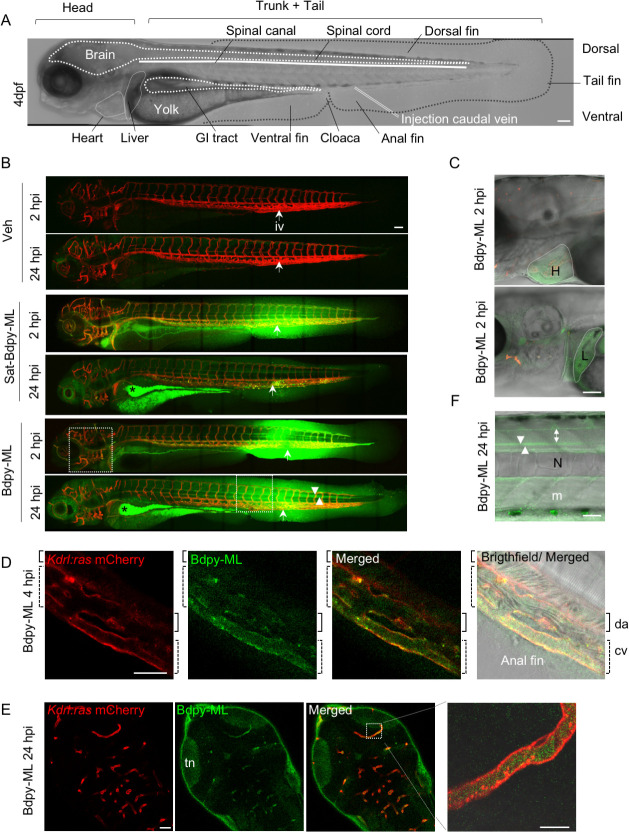
In vivo diffusion of Bdpy-ML in zebrafish larva.(A) Brightfield lateral view of a larva at 4 dpf with main anatomical structures highlighted. GI, Gastro-intestinal. (B) lateral views of 4dpf zebrafish Kdrl:Ras mCherry larvae, 2 and 24 hours post injection (hpi) in the caudal vein with vehicle (Veh), Sat-Bdpy-ML or Bdpy-ML. Images are maximal z projections of confocal tile scan images acquired on same larvae over time; mCherry fluorescence shown in red, Bdpy in green. Arrowheads indicate the spinal canal, arrows indicate the site of intravenous injection (iv), stars show accumulation in the GI tract at 24h. Areas delimited by dotted lines in (B) are shown at higher magnification in (C, 2 hpi) and (F, 24 hpi). Scale Bar 100 μm. (C) Enlarged views (with transmitted light image overlaid on fluorescence) of (B) showing accumulation of Bdpy-ML in heart and liver 2 hpi. (D) Detail of the vasculature in the ventral region of the tail showing longitudinal section of blood vessels and colocalization of Bdpy-ML with mCherry in endothelial cells of the caudal vein 4 hpi. N: notochord, cv (dotted brackets): caudal vein, da (brackets): dorsal aorta. (E) Dorsal view of the head with sections of blood vessels showing blood circulating Bdpy-ML and diffusion into the brain with accumulation in the tectal neuropil (tn) at 24 hpi. Right panel is an enlarged view a blood vessel in longitudinal section. (F) Enlarged view of the trunk in (B) showing preferential accumulation of Bdpy-ML in muscles (m), spinal canal (arrowheads) and spinal cord (double arrow) 24 hpi. N: notochord. (A, B, C, F): lateral views, dorsal top, anterior left; (D) lateral view, dorsal top right, anterior top left; (E) dorsal view, anterior down left. Scale bars (C-E) 40 μm. All images are representative of at least 10 larvae from 3 independent experiments. Images in (C-F) correspond to one focal plane (z = 2 μm).